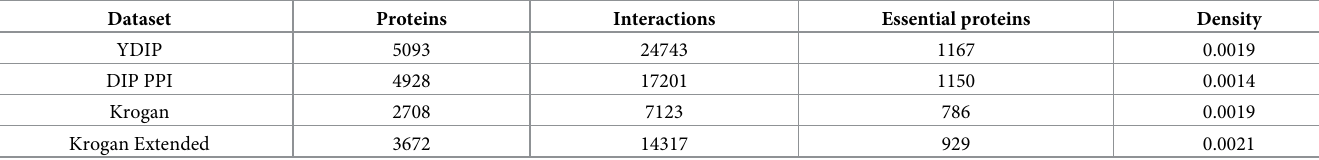
Table 1. The detailed information of four PPI